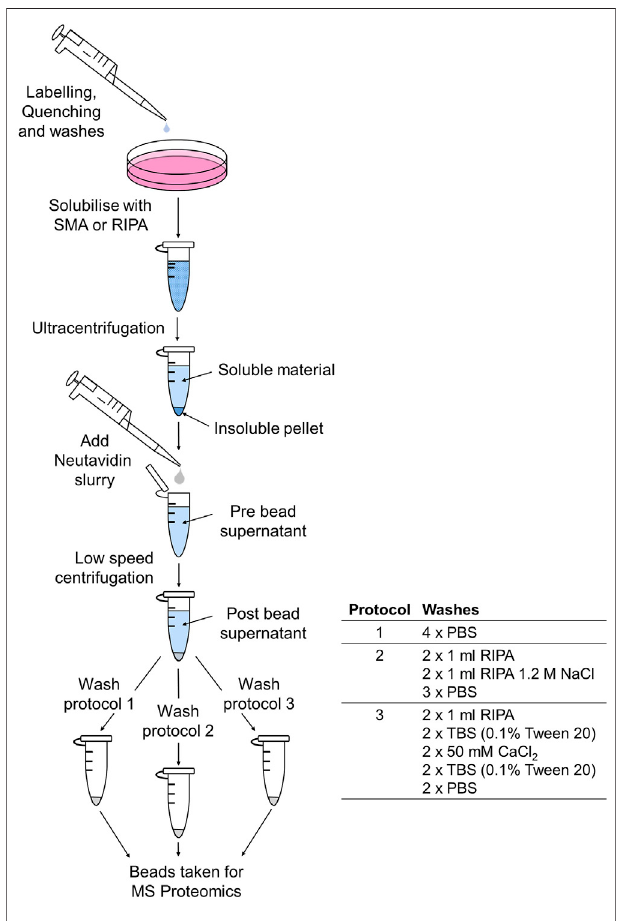
FIGURE 1 | Schematic to show the biotinylation, extraction, and puri fi cation protocol for MS-proteomic analysis.